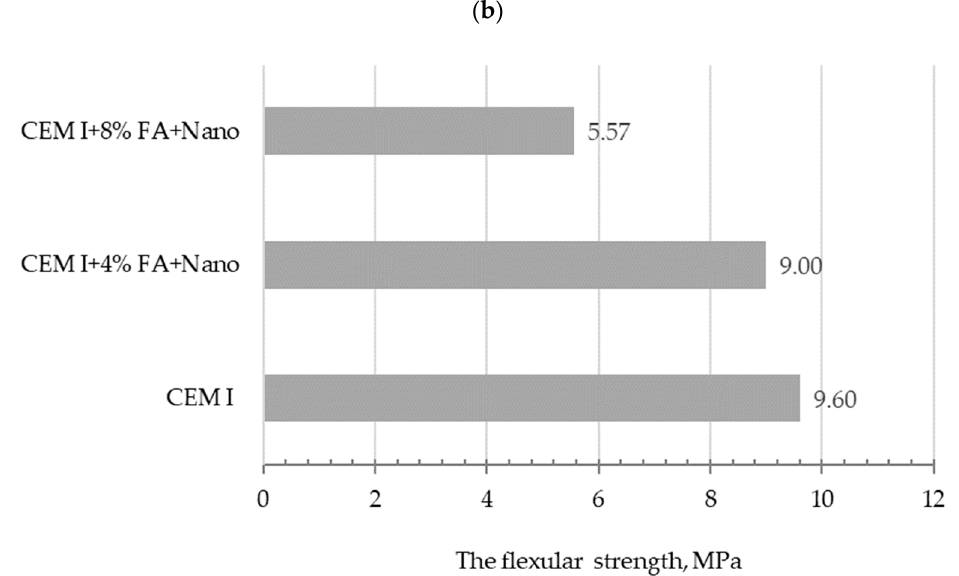
Figure 10. Strength of cement mortars with the addition of FA modified with nanosilica after 28 days of curing: ( a ) compressive strength; ( b ) flexural strength.